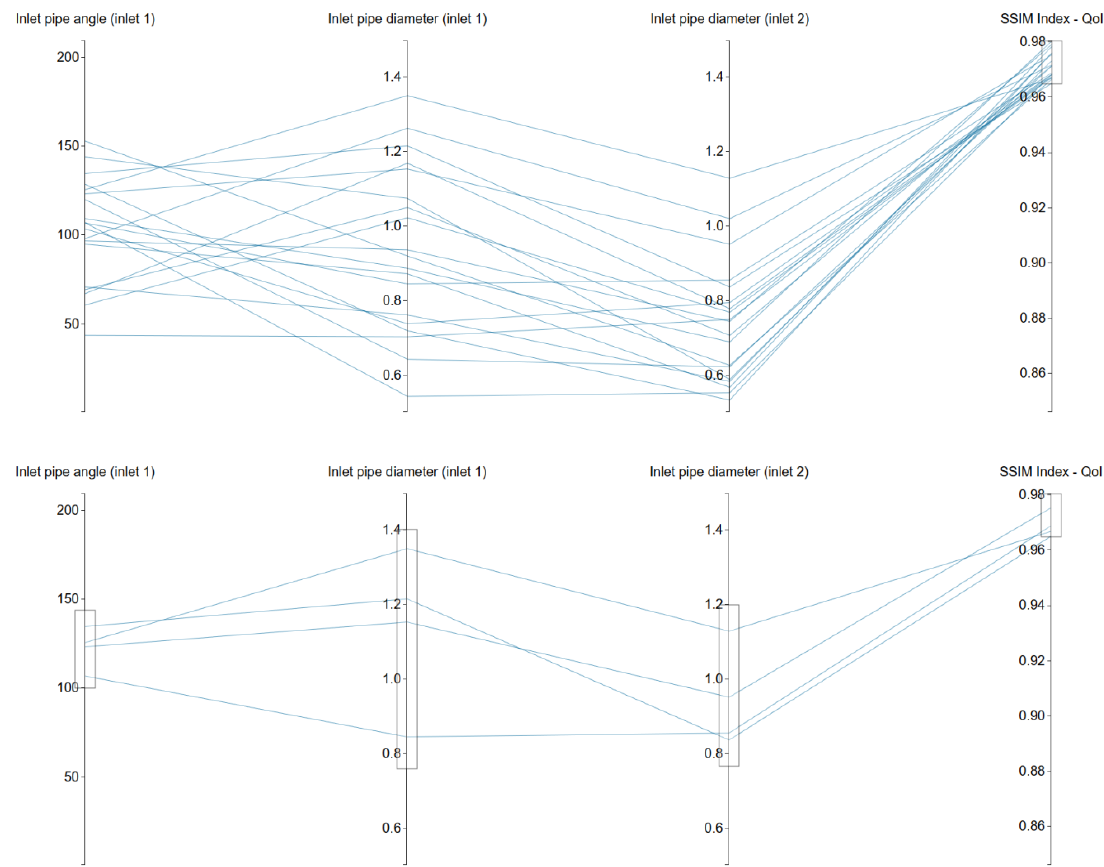
Figure 13. Parallel coordinates plot with filters. In the top image, the QoI has been filtered (0.9660 ≤ SSIM ≤ 1). In the bottom figure, we apply additional filters to the design